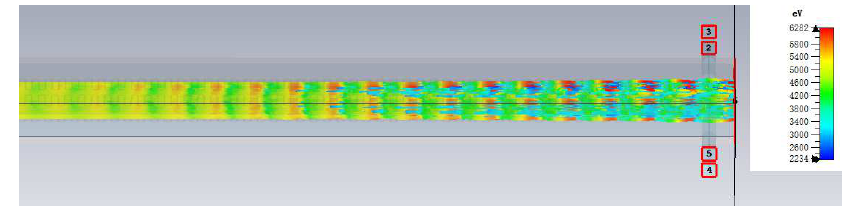
Figure 5. Typical electron bunching along a longitudinal direction. Figure 6. Electron kinetic energy versus longitudinal distance.